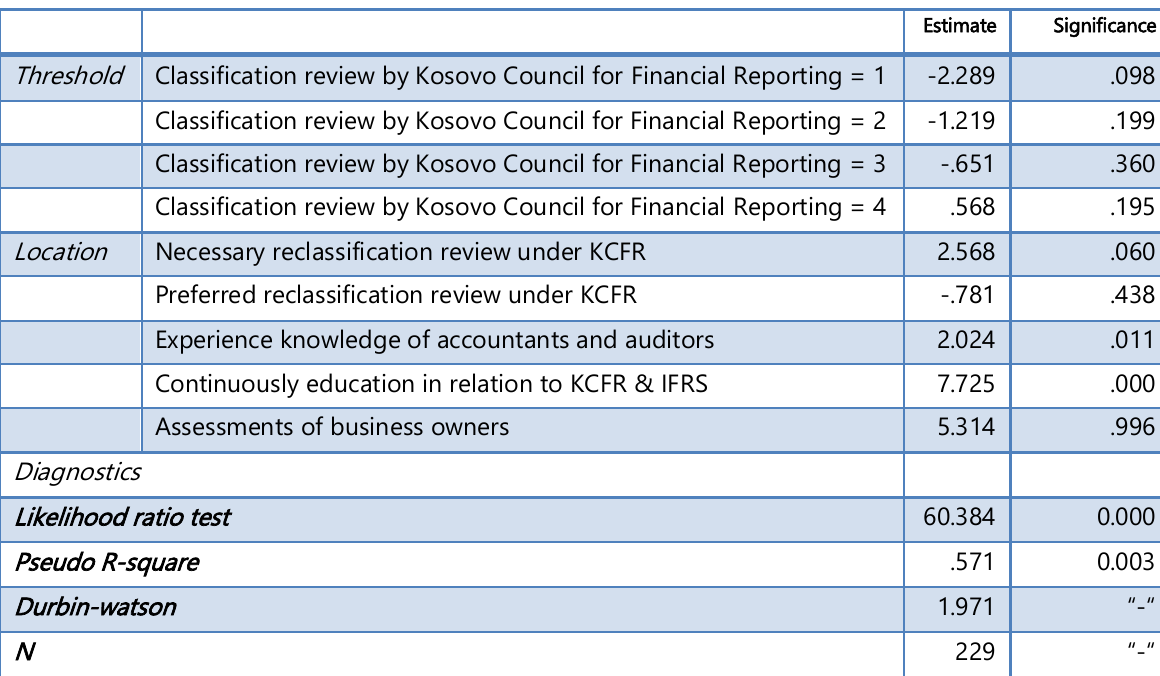
Table 5: Parameter Estimates (Source: Authors‟